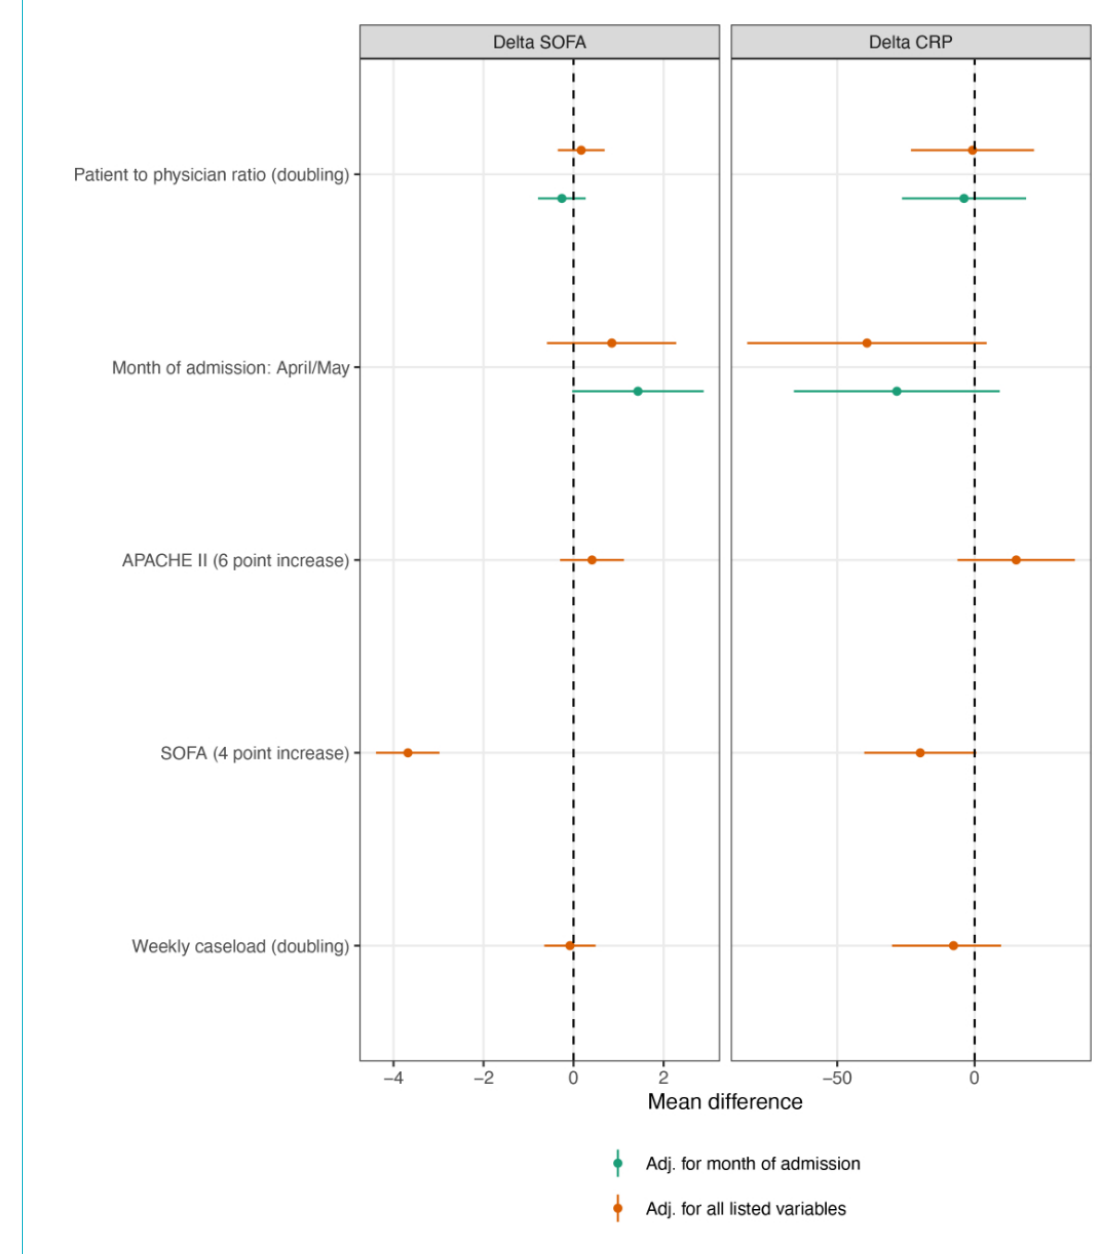
Figure 6: Patient-to-physician ratio and delta SOFA, delta CRP. APACHE II = Acute Physiology and Chronic Health Evaluation II, SOFA = Se- quential Organ Failure